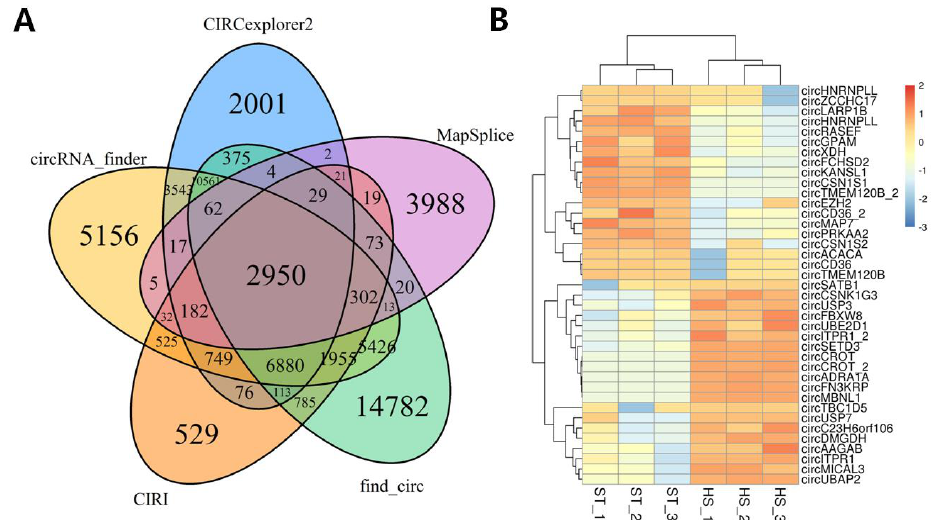
Figure 3. CircRNAome analysis of the mammary gland of dairy cows under heat stress. ( A ) Common circRNA candidates identified by all five approaches; ( B ) Heatmap, showing significantly differentially expressed circRNA candidates. ST, the appropriate temperature group; HS, heat stress group.